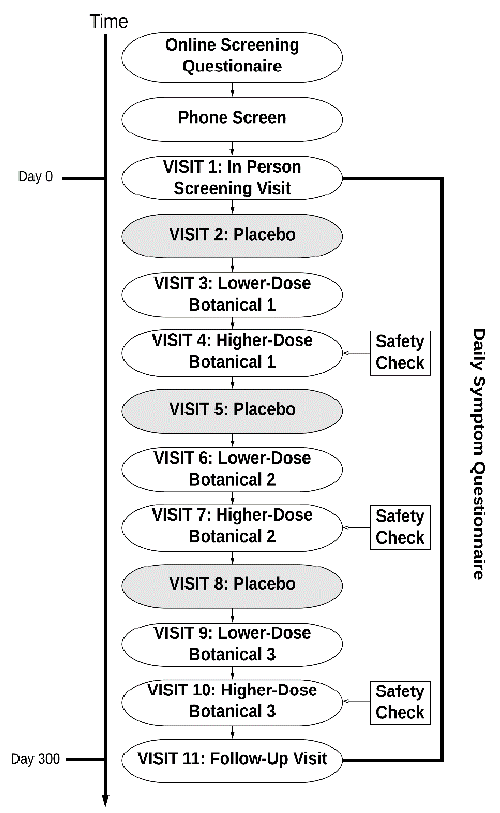
Figure 1. Study event flow. Participants took three of the tested compounds in the following order: placebo, lower-dose botanical, and higher-dose botanical.